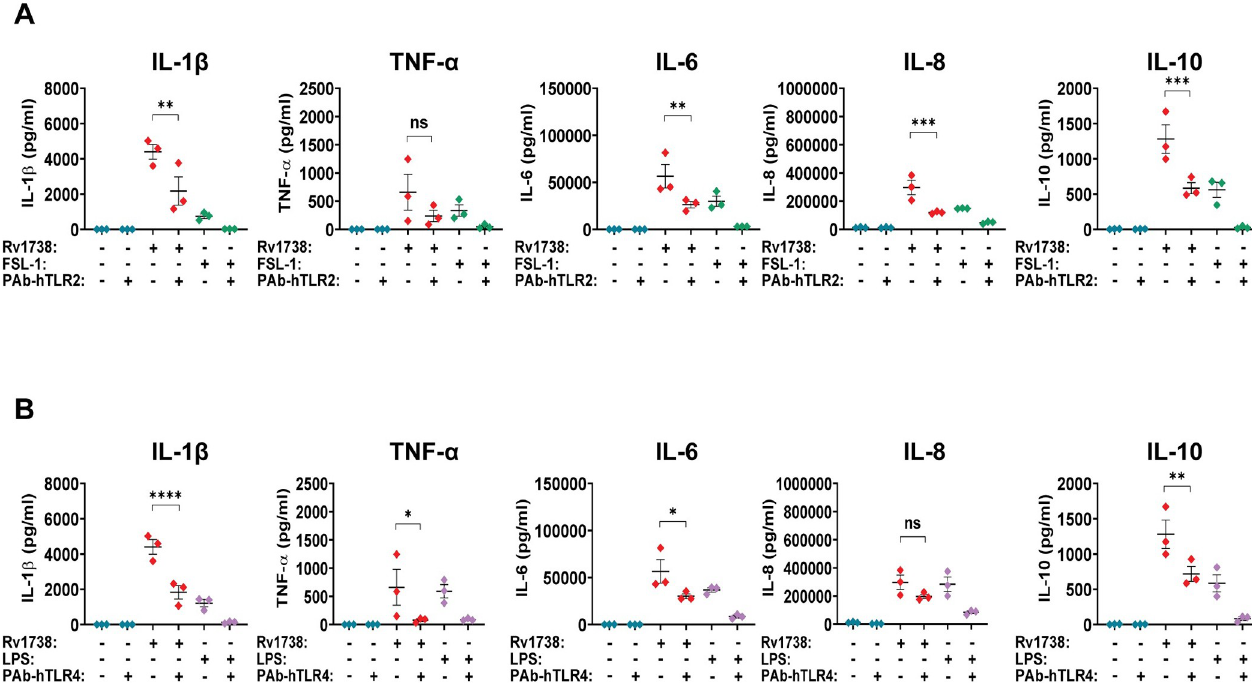
Fig 5. Levels of pro- and anti- inflammatory cytokines stimulated by protein Rv1738 in hPBMCs via hTLR2 and hTLR4 pathways. (A) Cytokine production from hTLR2 blocking group. (B) Cytokine production from hTLR4 blocking group. The ligand-binding pockets of hTLR2 and hTLR4 in human PBMCs were blocked with 5 μ g/ml of anti-hTLR2 and anti-hTLR4 antibodies, respectively, for 1 hour. Recombinant protein Rv1738 (6.4 μ g/ml) was subsequently added and incubated for the next 24 hours. Blockings of untreated cells, FSL-1 (100 ng/ml) and LPS (1 μ g/ml) were applied as the systemic controls. A set of cytokines (IL-1 β , IL-6, IL-8, IL-10 and TNF- α ) in the culture supernatants was quantitated by CBA assay. Data were evaluated by flow cytometry, analyzed by FCAP array software and represented as mean ± SEM of 3 individual subjects (each experiment was done in duplicate). One-way ANOVA with Sidak’s post hoc test was used for statistical analysis. p values were represented with asterisk symbols ( � p < 0.05 �� p < 0.01, ��� p < 0.001 and ���� p < 0.0001).